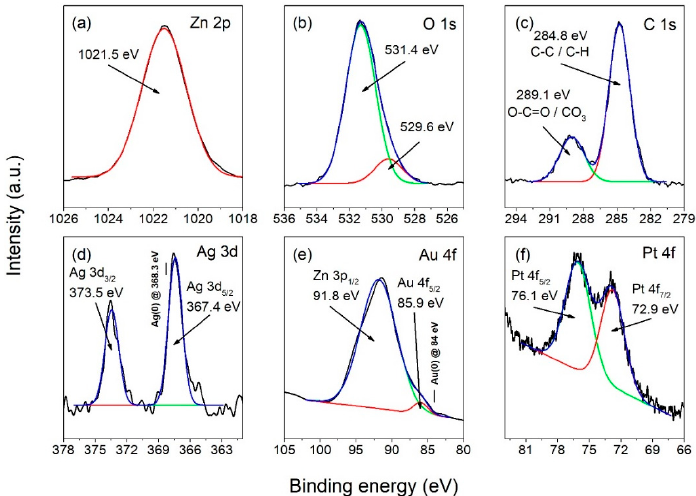
Figure 8. High resolution XPS spectra of doped ZnO nanoparticles with fitted spectra for ( a ) Zn 2p, ( b ) O 1s, ( c ) C 1s, ( d ) Ag 3d, ( e ) Au 4f, and ( f ) Pt 4f. Red and green curves represent fit peaks while blue curve represents cumulative fit peak.